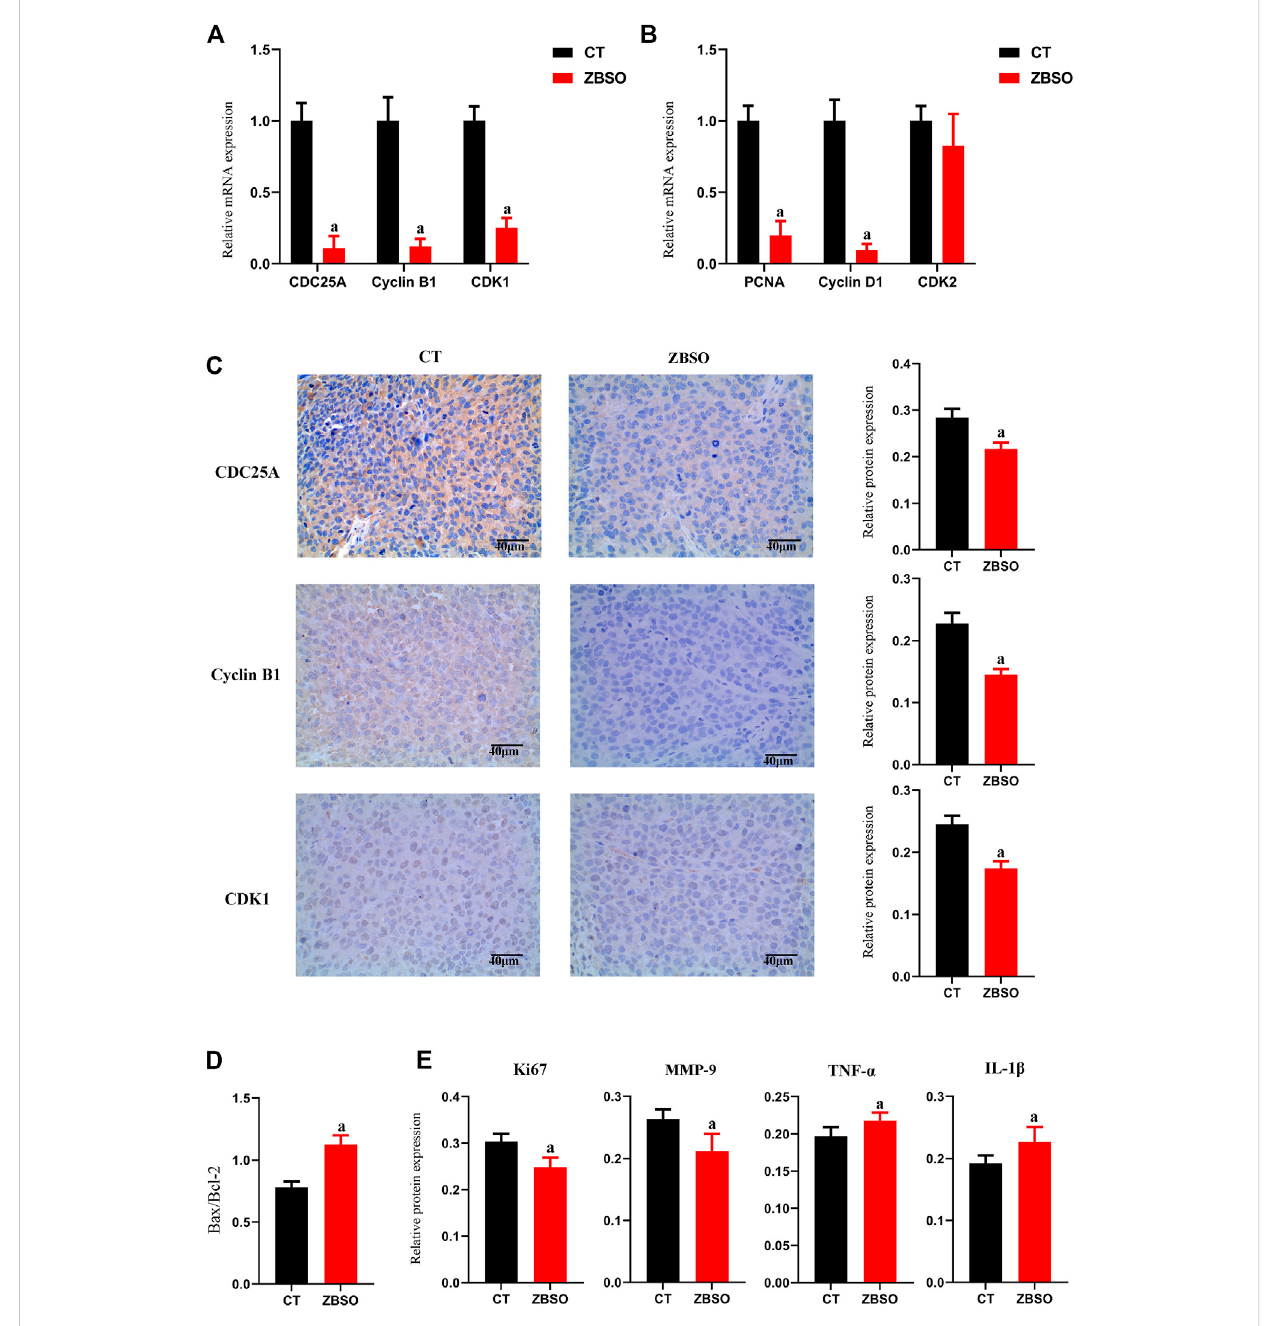
FIGURE 3 Protein and mRNA expression of xenograft tumor tissue in nude mice. (A,B) RT-qPCR analysis of relative mRNA expression levels of cell cycle-related genes in xenograft tumor tissues from nude mice. (C – E) Immunohistochemical analysis of target protein expression in xenograft tumor tissues from nude mice. Images of immunohistochemistry were magni fi ed ×400. Scale bar 40 μ m ( a p < 0.05 compared with control